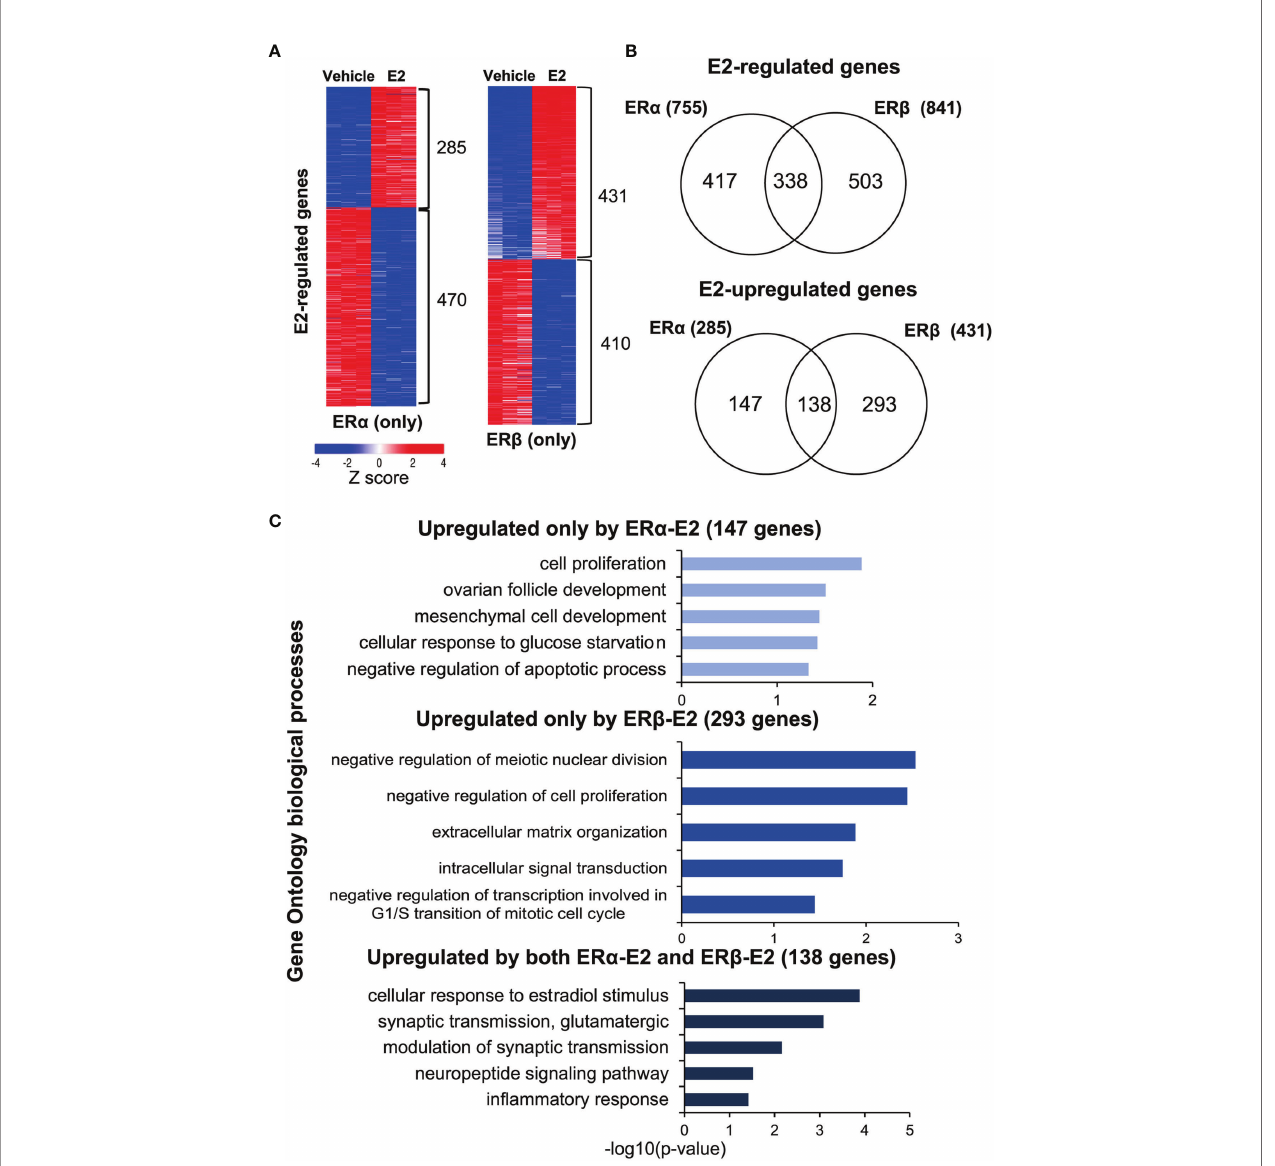
FIGURE 4 | ER a and ER b regulate the transcriptome differently. (A) Heatmap illustrating E2-regulated gene expression pro fi les by ER a (left) and ER b (right), as determined by RNA-seq. Red indicates higher expression, blue lower. The heatmap was generated using the web-based tool Morpheus (https://software. broadinstitute.org/morpheus/) and the gene expression data (log2fold change) were normalized by Z-score. (B) Overlap of all E2-regulated genes (top), and E2- upregulated genes speci fi cally (bottom) by ER a or ER b . (C) Enrichment analysis of biological functions related to the E2-upregulated genes (corresponding to the groups in B, lower panel) for ER a (147 genes, top), ER b (293 genes, middle), and by both receptors (138 genes, lower graph) using